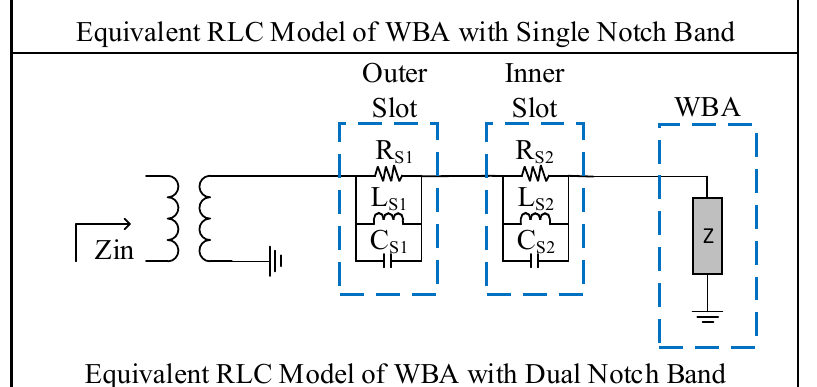
Figure 5. RLC equivalent model of wide band antenna with and without notch-bands. As the current distribution is perturbed due to slots on the radiating patch, the path of the current is elongated. The length of the current path exhibits the series inductance, whereas the etched gaps of the slots accumulate the charge, hence determines series capacitance. Collectively, this behavior can be represented by the equivalent lumped element circuit with LC configuration. The equivalent lumped element parallel RLC circuit for the proposed antenna is illustrated in Figure 5. L S 1 , C Si , and R Si represent the inductance, capacitance, and radiation resistance for i th radiating mode at each resonant frequency band, respectively. The lumped effect of the slots causing the resonant frequency is represented as a series combination of all lumped elements with an inductive patch antenna and ground plane as a capacitive load. Both inductive and capacitive effects as well as feeding effects are considered for higher-order modes generation and significantly contribute to the input impedance of the antenna. 2.6. Parametric Analysis Parametric analysis of the key parameters of the antenna is performed to investigate their effects on the performance of the antenna, as depicted in Figure 6. As shown in Figure 6a, when the length of the truncated corner was changed from 15.55 mm to 12.73 mm, all the resonances were shifted toward the higher side. An increment in bandwidth was observed for the third while the bandwidth of the first resonance decreases considerably, as depicted in Figure 6a. On the other hand, when the value of P X was increased from 15.55 mm to 18.35 mm, all resonances shift toward the lower side along with a decrement in the bandwidth of the third resonance. The increase and decrease in